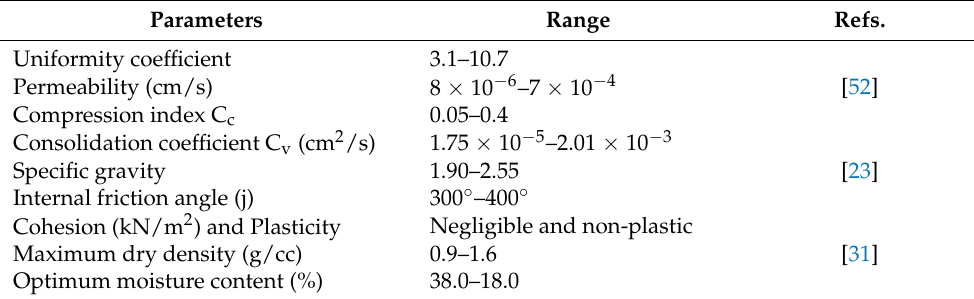
Table 2. Common properties of